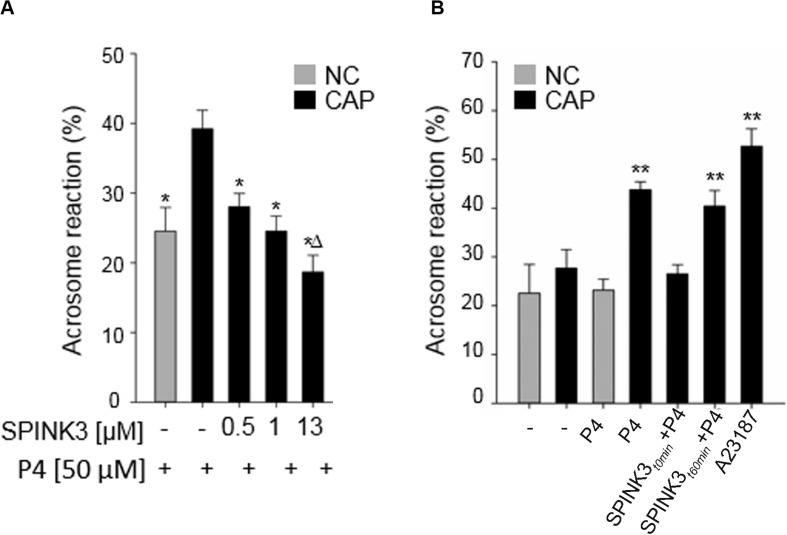
Effect of SPINK3 on acrosome reaction (AR). (A) Different SPINK3 concentrations were added at the beginning of the incubation time in either non-capacitating (NC, gray bars) or capacitating (CAP, black bars) medium (60 min at 37°C). AR was induced by 50 μM progesterone (“P4”) (data represent mean ± SE; n = 3). *p < 0.05 respect to control Progesterone-induced capacitated cells; Δp < 0.05 compared to 1 μM SPINK3 treatment. (B) SPINK3 (13 μM) was added either at the beginning (SPINK3t0 min + P4) or at the end of capacitation (SPINK3t60 min + P4). Progesterone (50 μM) was always added after capacitation was completed (data represent mean ± S.E.; n = 8); **p < 0.05 with respect to cells treated with SPINK3 at the beginning of capacitation (SPINK3 + P4).